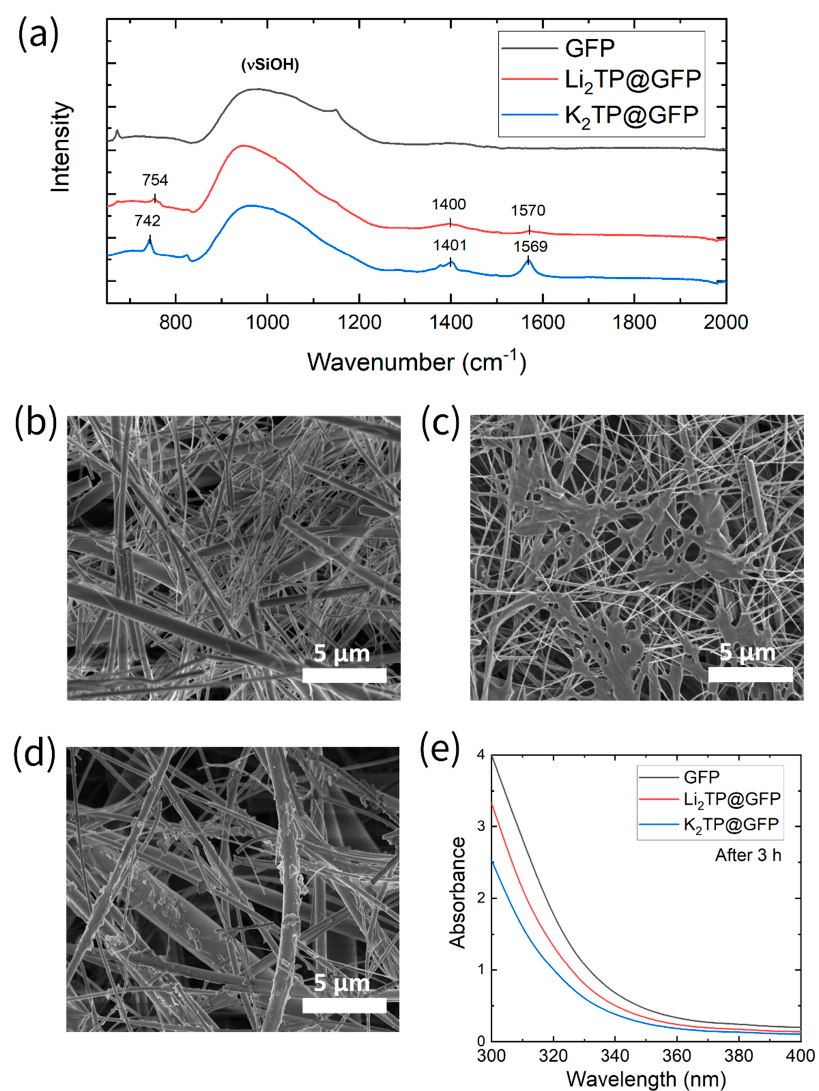
Figure 3. Characterizations of separators, including ( a ) FTIR spectra of modified and unmodified GFP, as well as SEM images of ( b ) GFP, ( c ) Li 2 TP@GFP, and ( d ) K 2 TP@GFP. ( e ) Absorbance spectra of DOL:DME solution after 3 h against 0.1 M Li 2 S 6 solution in separator diffusion test.